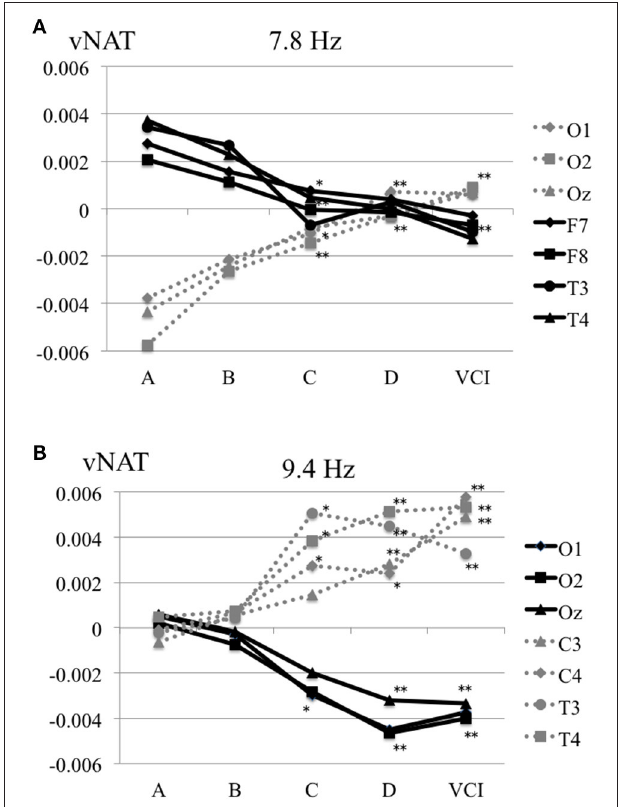
FIGURE 5 | Mean vNAT map at 9.3 Hz frequency range for (A) group B, (B) group C, (C) group D, (D) VCI group, respectively. The colorbar indicates the range of z-scores in comparison with control group A: Green indicates normal spectrum steepness. Red and blue indicate spectrum blur and spectrum sharpness, respectively. L, left; R,